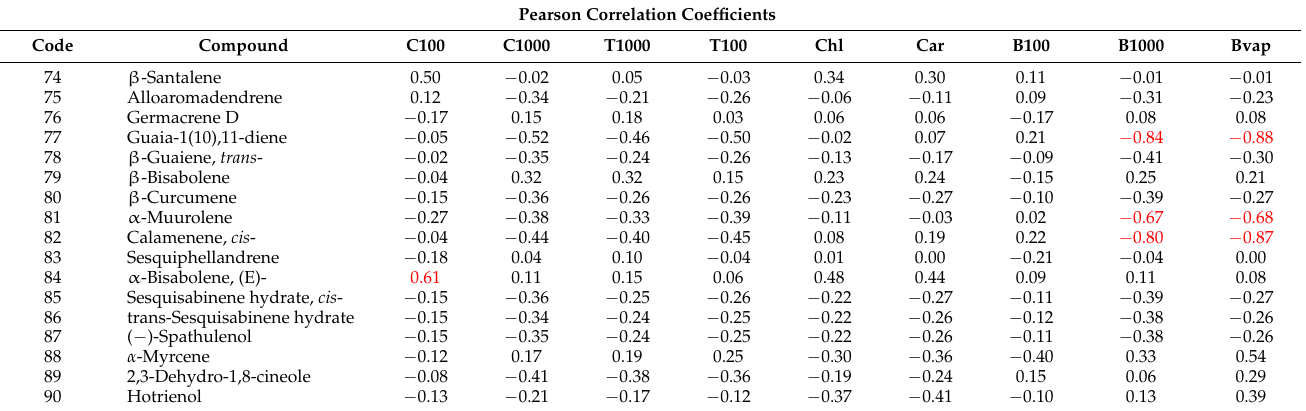
Pearson Correlation